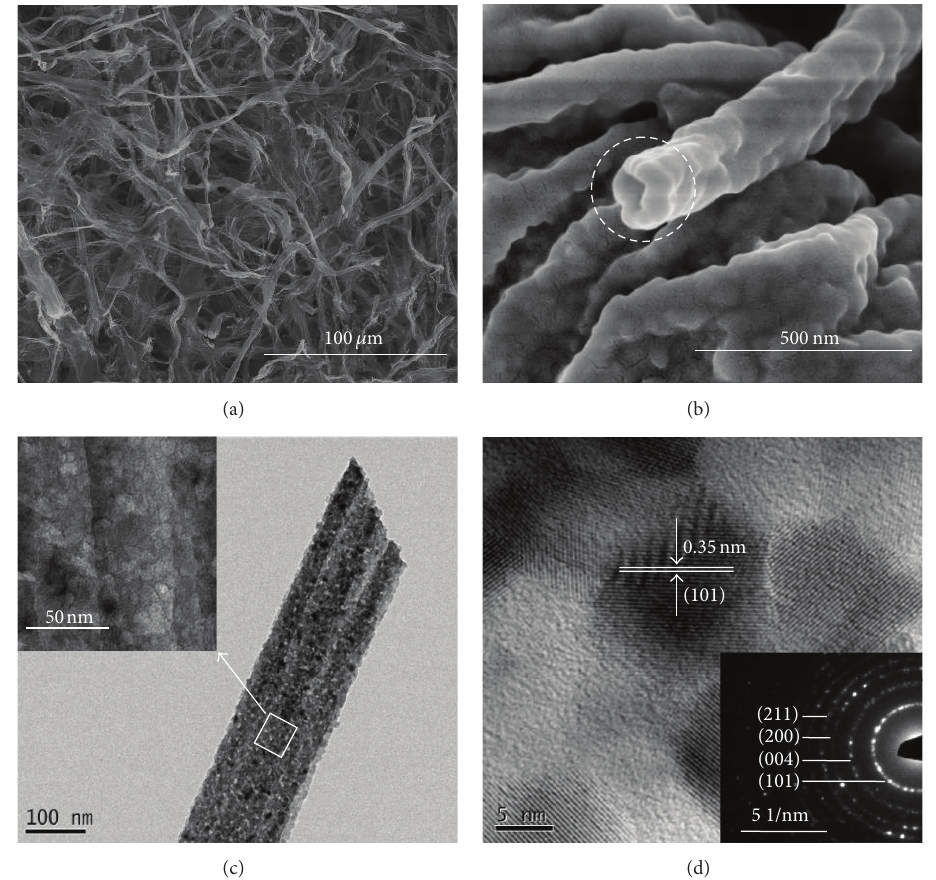
Figure 2: Micromorphology observations of prepared porous TiO 2 nanotubes. (a) FE-SEM image. (b) Further magnified SEM image. (c) TEM image of individual titania nanotube and magnified TEM image of tube wall (insert). (d) HR-TEM image and SAED pattern (insert).